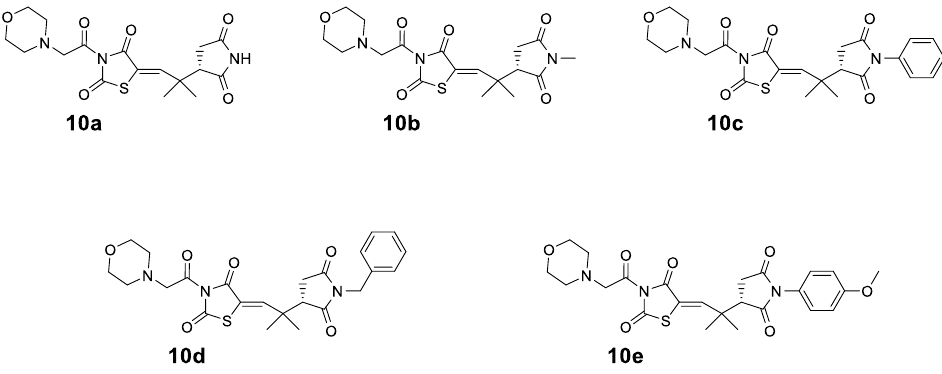
Figure 2. Structures of the synthesized compounds 10a – e .